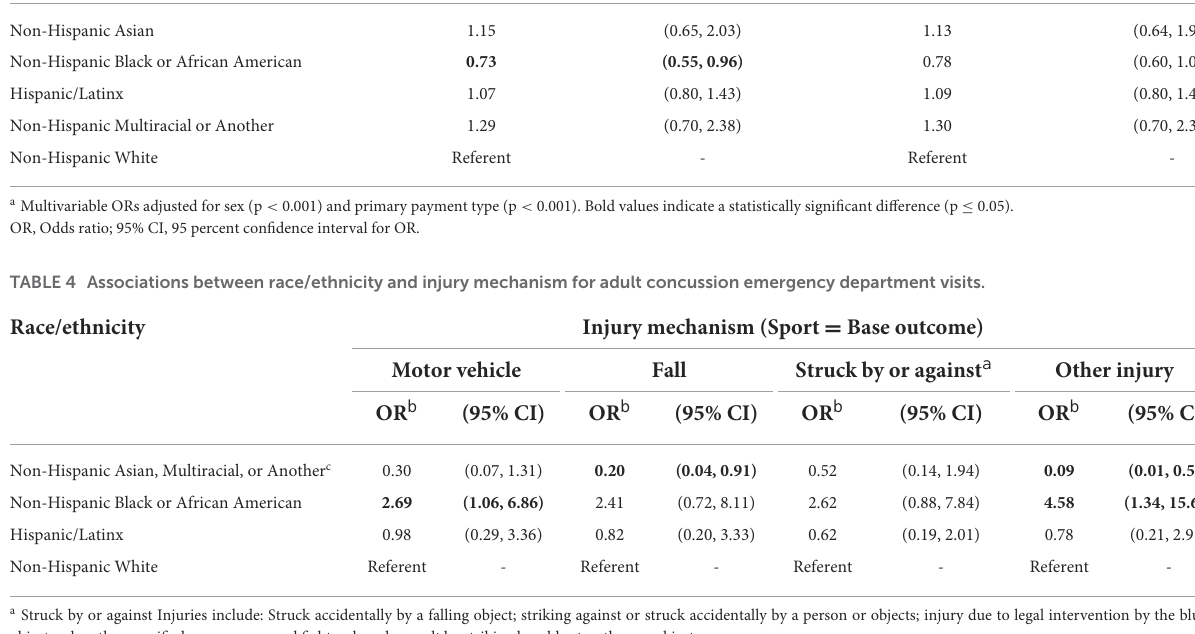
TABLE 3 Association between race/ethnicity and concussion emergency department visits. Race/ethnicity